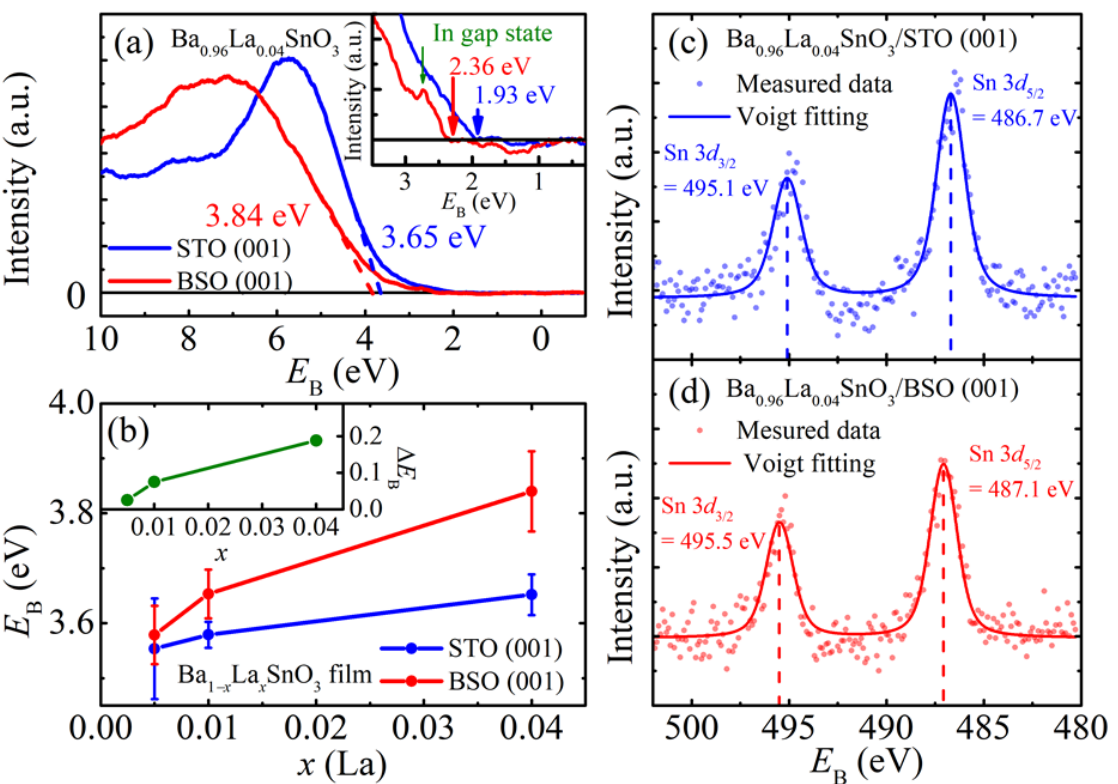
Figure 4. ( a ) The UPS spectra of Ba 0.96 La 0.04 SnO 3 films grown on STO (001) (blue lines) and BSO (001) (red lines) substrates. The inset shows the same UPS spectrum enlarged near the tail. ( b ) A summary of E B ’ s of the valence band maximum (VBM) estimated from the UPS spectra of BLSO films grown on both STO (blue) and BSO (red) substrates. The inset shows the VBM difference between the BLSO films grown on BSO (001) and STO (001) substrates ( c , d ) XPS spectra near the Sn 3 d core level in Ba 0.96 La 0.04 SnO 3 films grown on STO (001) (blue) and BSO (001) (red). Scattered symbols represent the measured data, and the solid lines are the fitted curves by the Voigt profile. Dashed lines in ( c , d ) indicate the peak positions of each spectrum.